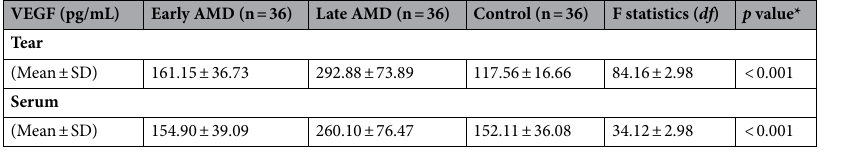
Table 2. Comparison of mean VEGF levels between the groups. *ANCOVA test applied after adjustment for age, sex, race, smoking and alcohol consumption, and comorbidities. p < 0.05 was considered significant.